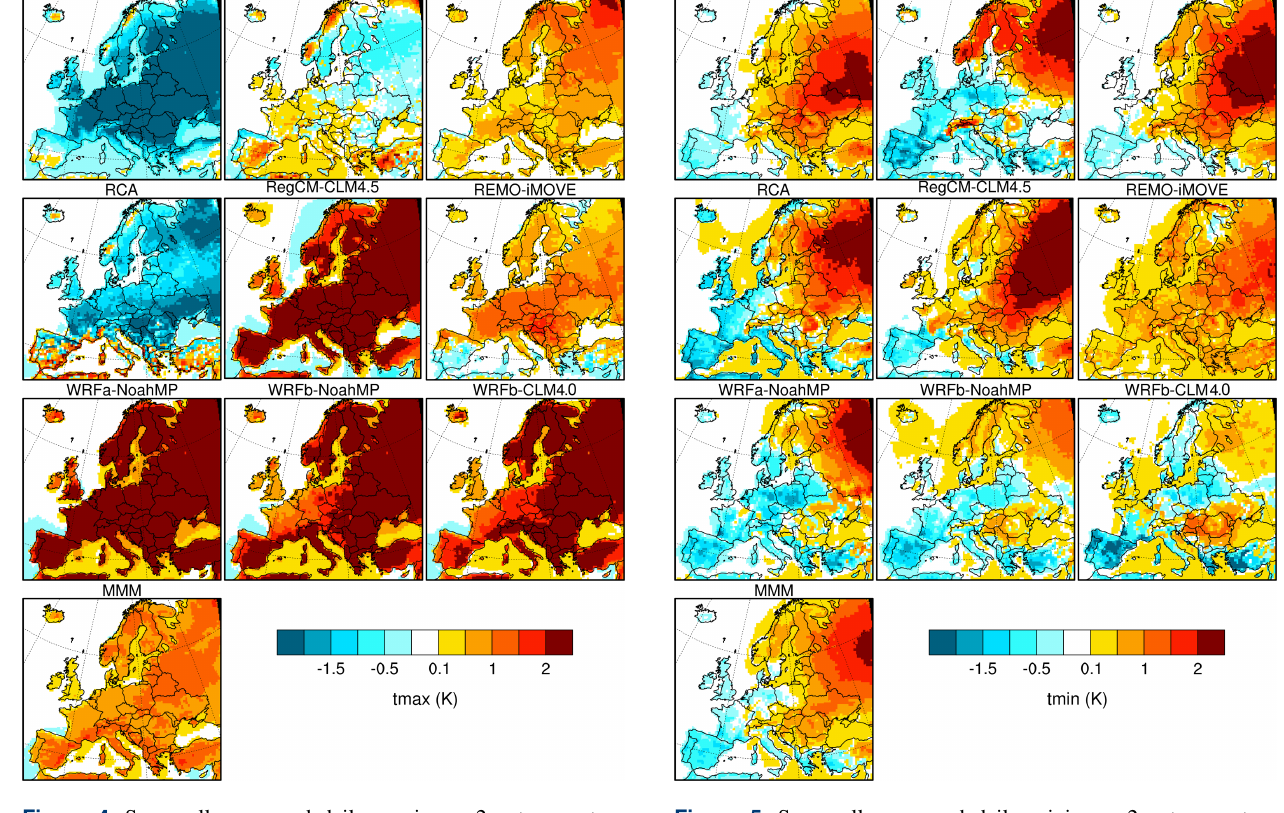
Figure 4. Seasonally averaged daily maximum 2m temperature (FOREST minus GRASS) for summer (JJA).